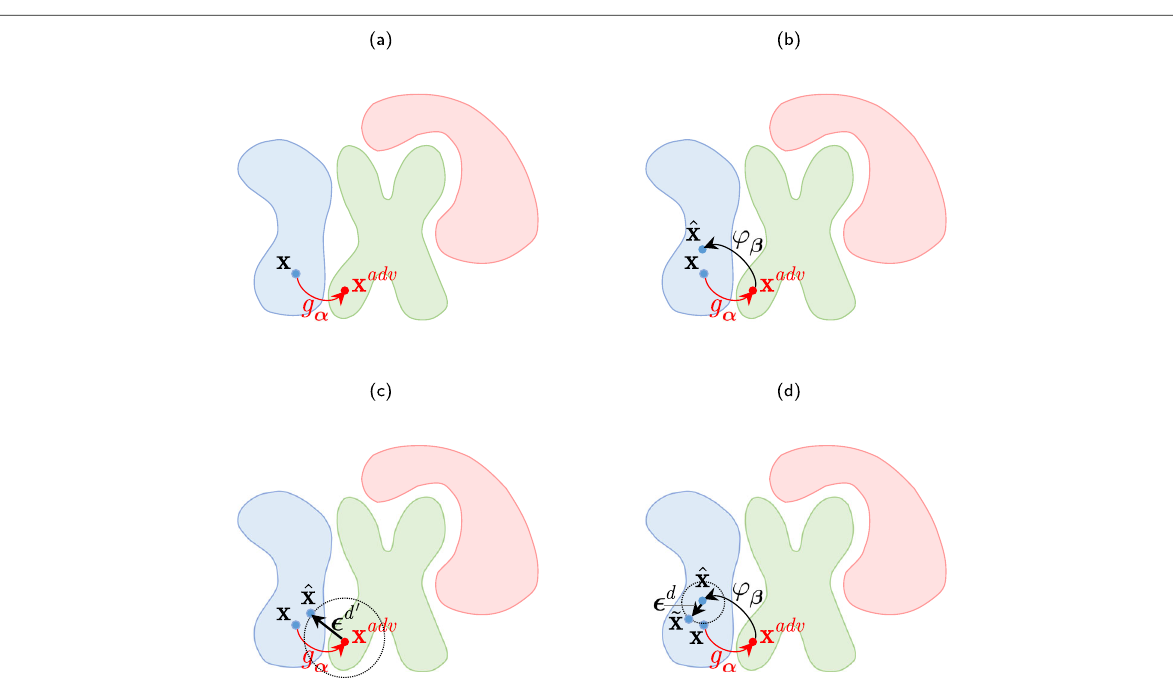
Fig. 4 The attacker-defender game in adversarial classification: a the attacker produces an adversarial example x adv from a host x by a mapper x adv = g α ( x , (cid:3) ) ; b the defender answers by the pre-filtering ϕ β ( x adv ) to obtain an estimation ˆ x on the original host class manifold; c an alternative defense strategy by a randomization of input adversarial image as ˆ x = x adv + (cid:3) d (cid:5) , the resulting sample will be outside attacker’s target class with a small probability that the resulting sample will be in the original host class that requires the classifiers retraining; d the proposed defense strategy consists of pre-filtering by ϕ β ( x adv ) and addition of defender’s randomized perturbation (cid:3) d : ˜ x = ϕ β ( x adv ) + (cid:3) d , such that (cid:6) (cid:3) d (cid:6) 2 2 (cid:7) (cid:6) (cid:3) d (cid:5) (cid:6) 2